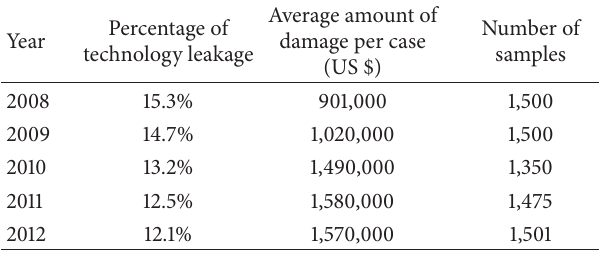
Table 1: The recent damage trends of technology leakage of SMB (2008 ∼